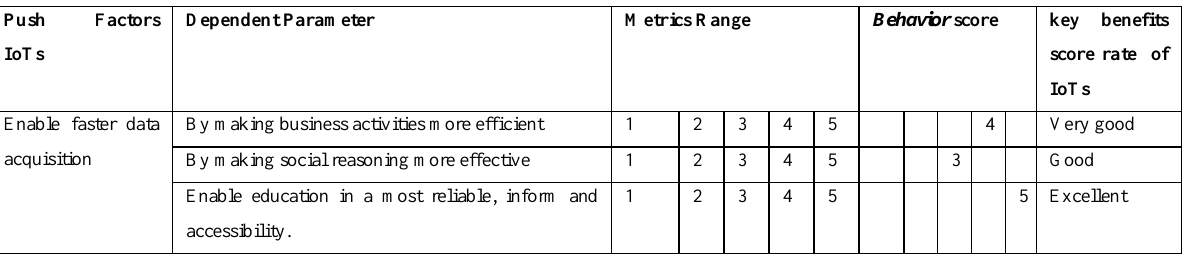
Table 4 determination of Behavior score Influence of IoTs base on aster data acquisition. Source: